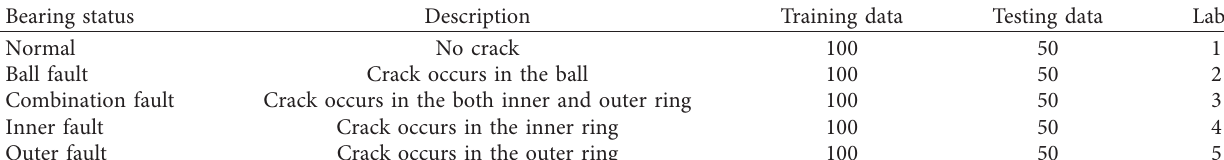
Table 8: Sample description under five bearing conditions.